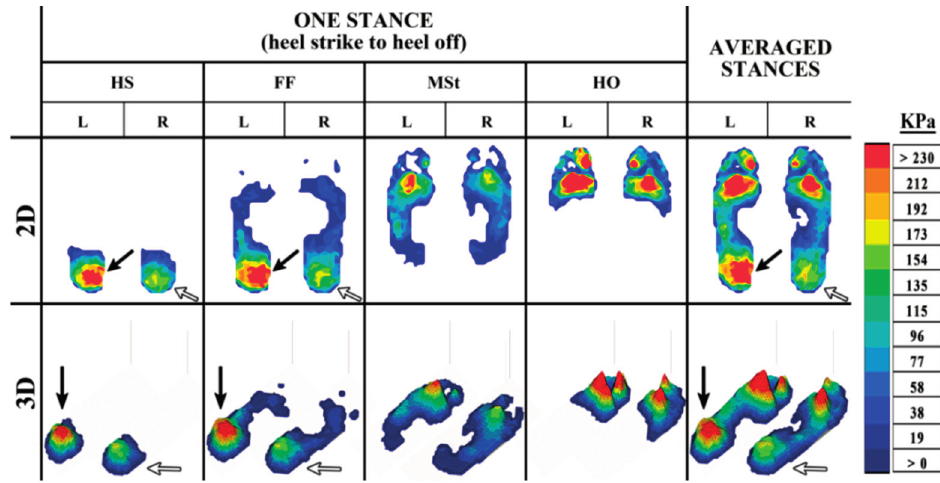
Figure 5. The 2D and 3D representation of an in-shoe plantar pressure distribution resulting from subtalar joint and heel pain in the pathological foot during the stance phase of the gait cycle, from HS to HO, and the averaged pressure distribution from four